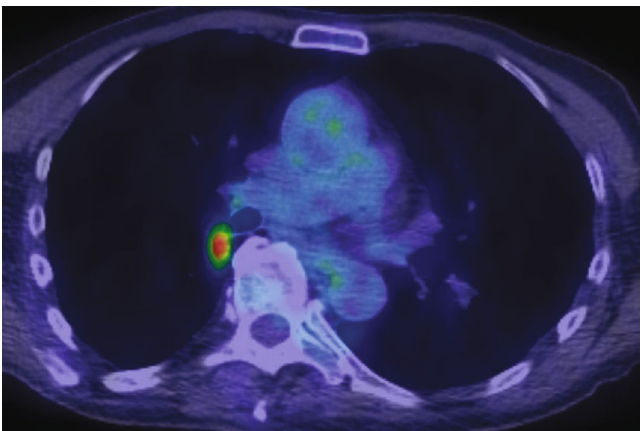
Figure 2: PET-CT scan showing the hypermetabolic nodule with a SUV of 5.7, concerning for a possible primary pulmonary